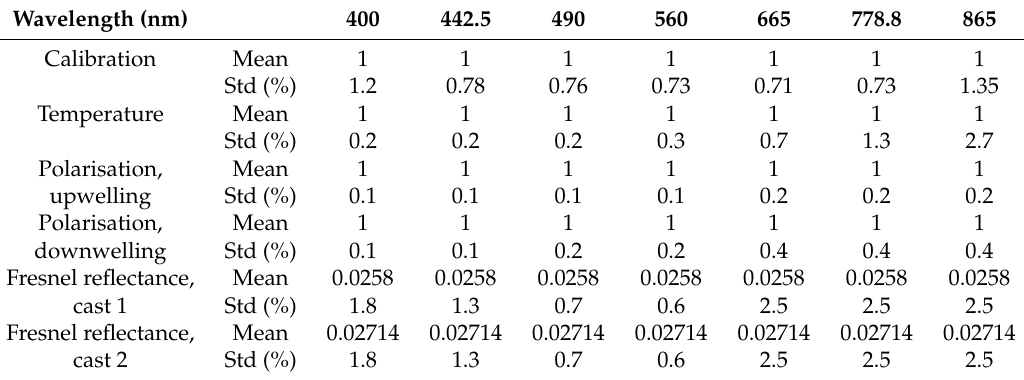
Table A1. The mean and uncertainty values used for each parameter for the radiance